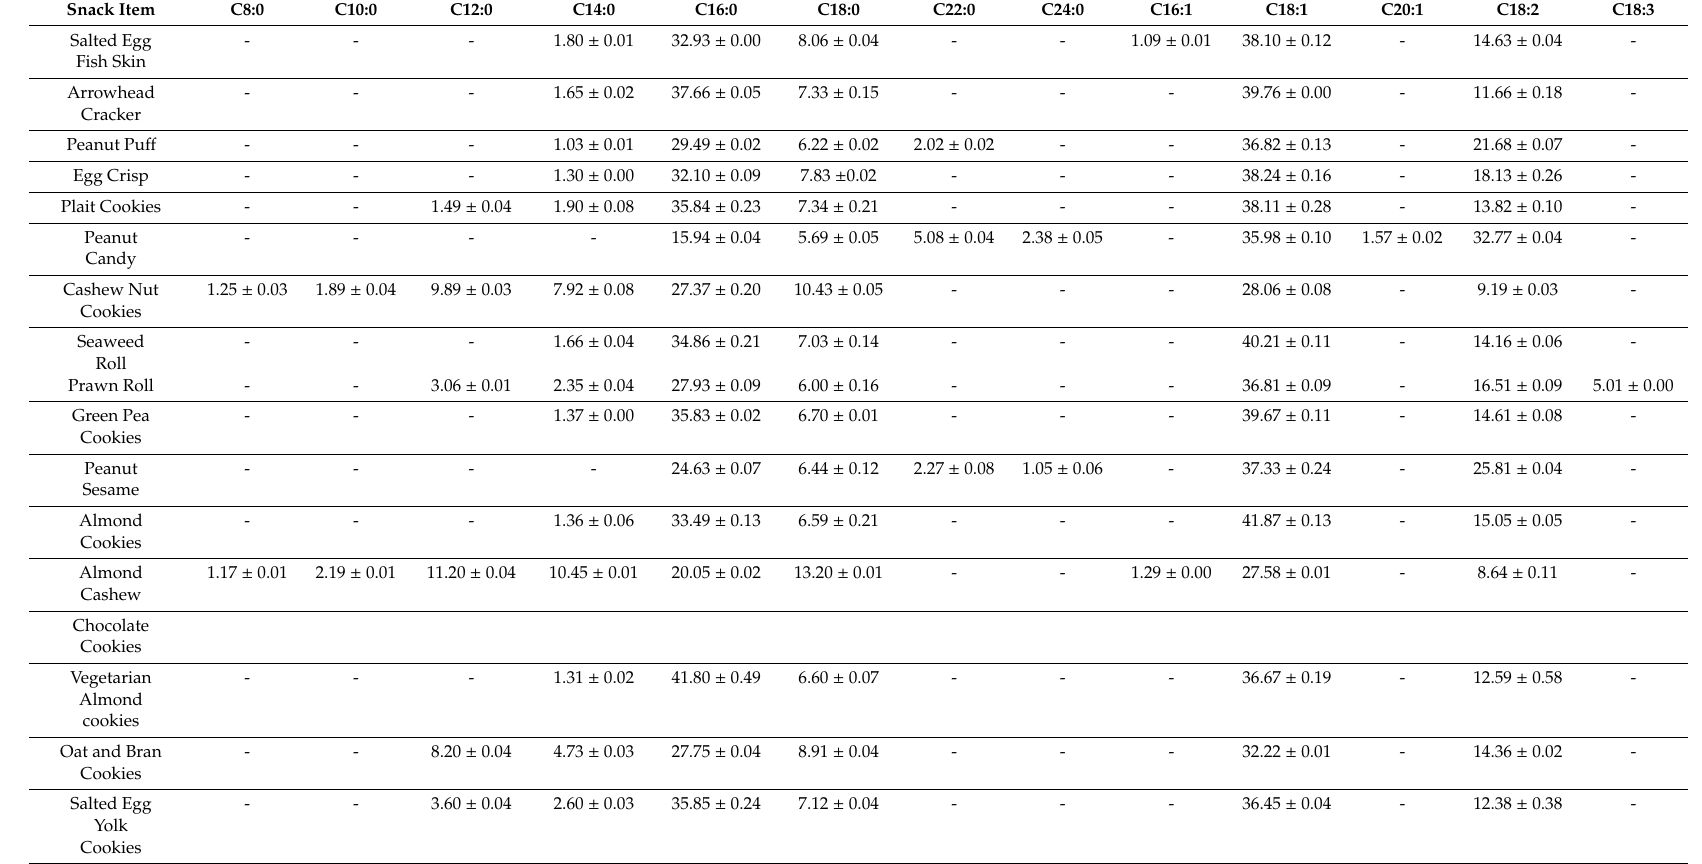
Table 2. Fatty acid profiles (% of total fatty acids) * of the commonly consumed CNY